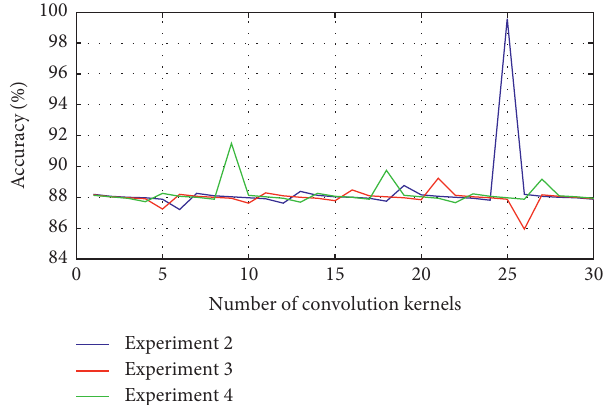
Figure 6: The relationship between the number of convolution kernels and the recognition